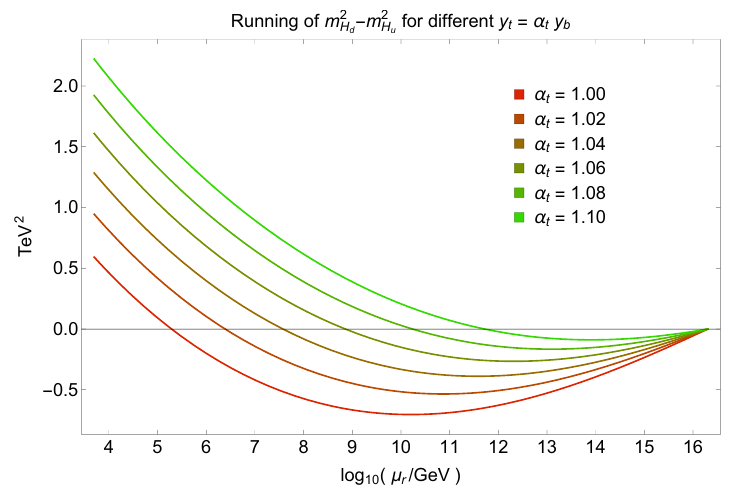
Figure 3 . The RGE running of m 2 (cid:0) m 2 for di(cid:11)erent values of the y t coupling. We can see the H d H u sensitivity of the value at M SUSY to the y t coupling: t - b uni(cid:12)cation signi(cid:12)cantly lowers the values, but already a % level mismatch in y t and y b noticably changes the mass parameter di(cid:11)erence.